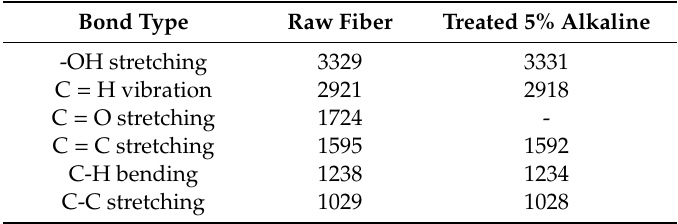
Table 3. Infrared transmittance bands (cm − 1 ) of raw and alkali-treated DPFs.